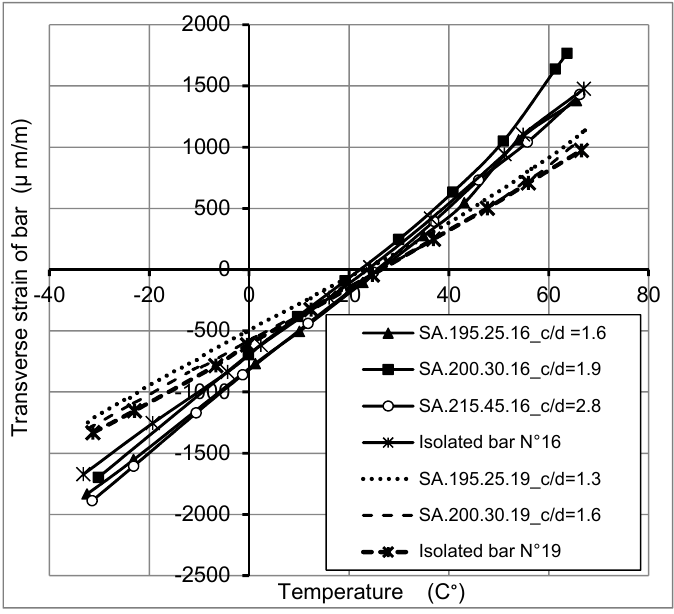
Figure 9. Experimental transverse strains of GFRP bars for concrete slabs SA having different concrete cover and FRP bars